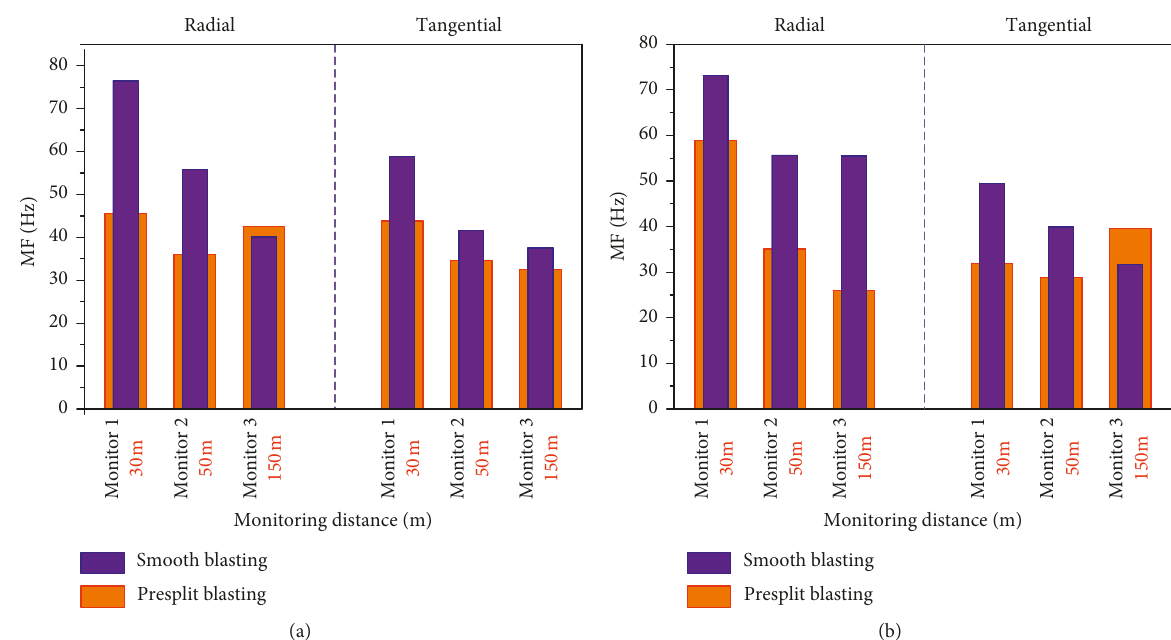
Figure 9: The mean frequencies of vibration signals from (a) main and (b) peripheral boreholes versus monitoring distances based on presplit and smooth